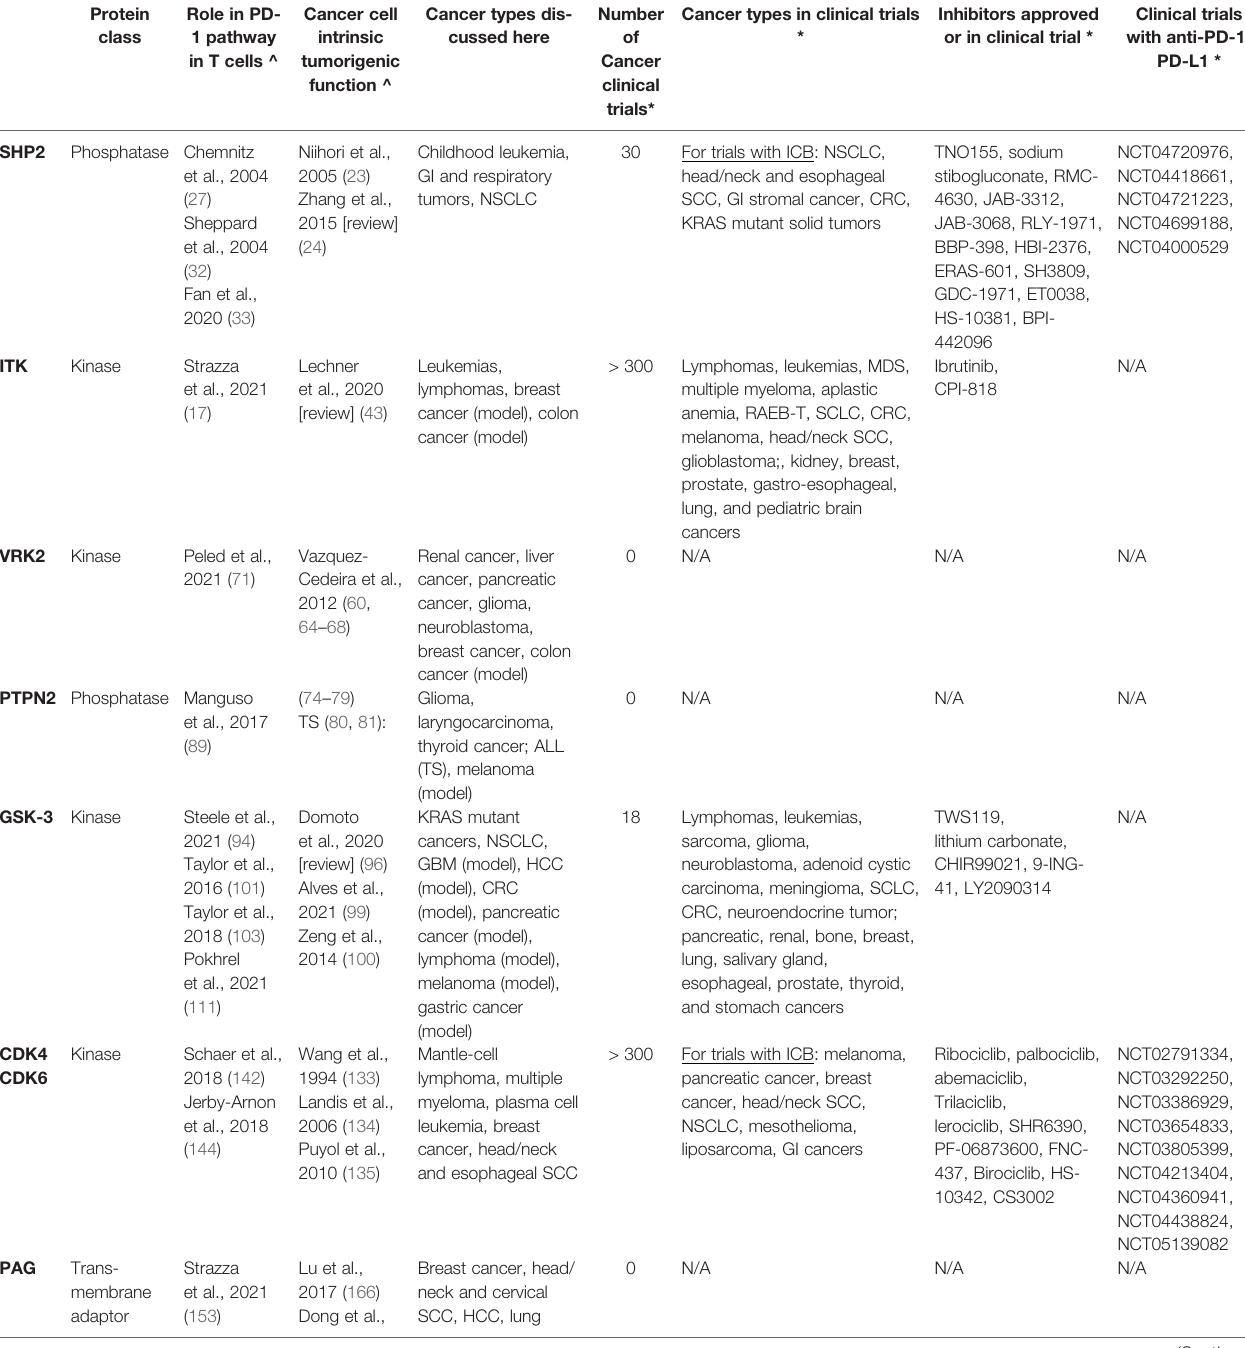
TABLE 1 | SHP2, ITK, VRK2, PTPN2, GSK-3, CDK4/6, and PAG all have evidence supporting their relationship to the PD-1 pathway in T cells and pro-tumorigenic role in cancer cells. Protein